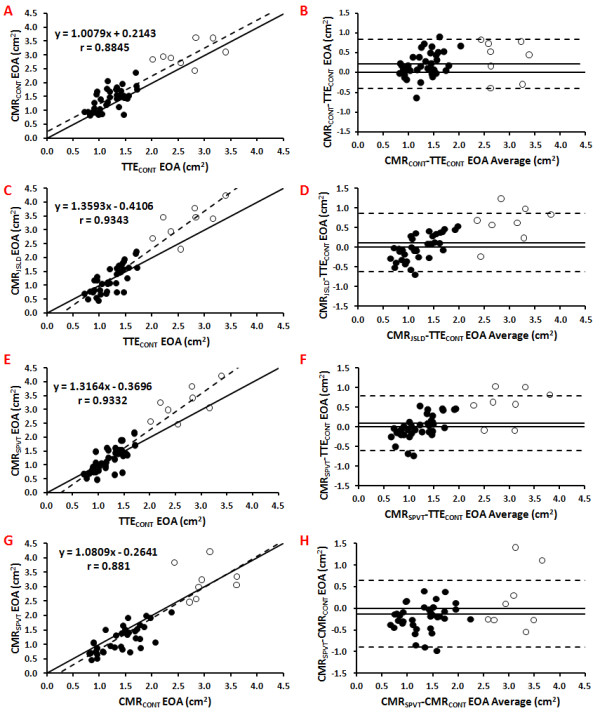
Correlation and agreement between the EOAs obtained in vivo by the different CMR and TTE methods. Panels A, C, E, and G show the Pearson correlation plots of CMRCONT vs. TTECONT, CMRJSLD vs. TTECONT, CMRSPVT vs. TTECONT, and CMRSPVT vs. CMRCONT, respectively. The dashed line is the regression line and the solid line is the identity line. Panels B, D, F, and H show the Bland-Altman plots of CMRCONT vs. TTECONT, CMRJSLD vs. TTECONT, CMRSPVT vs. TTECONT, and CMRSPVT vs. CMRCONT. The solid line is the mean bias and dashed lines are ± 1.96 standard-deviations lines. Non filled circles are healthy subjects.